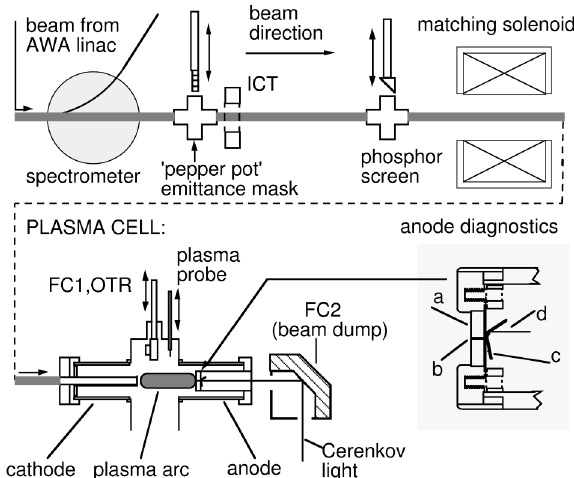
FIG. 6. Diagnostics beamline and plasma cell (shown without the plasma radial confinement solenoid). The anode diagnostics include (a) tungsten collimator with (b) 1 mm wide slit, (c) 500 m m thick quartz ˇCerenkov plate, and (d) mirror and outgoing